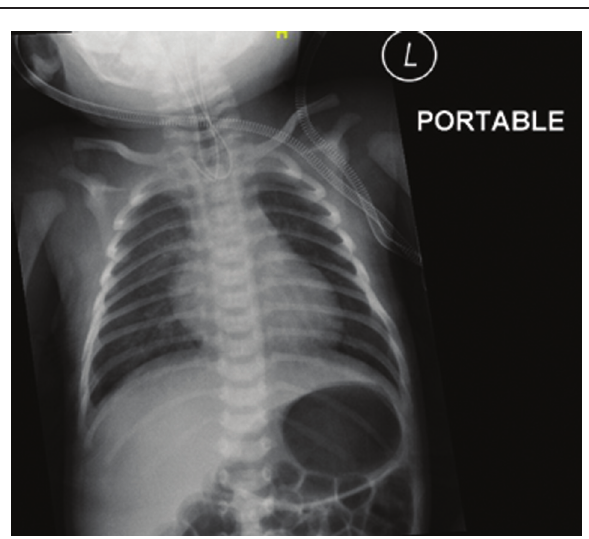
Chest radiograph revealed coiled Ryle ’ s tube.